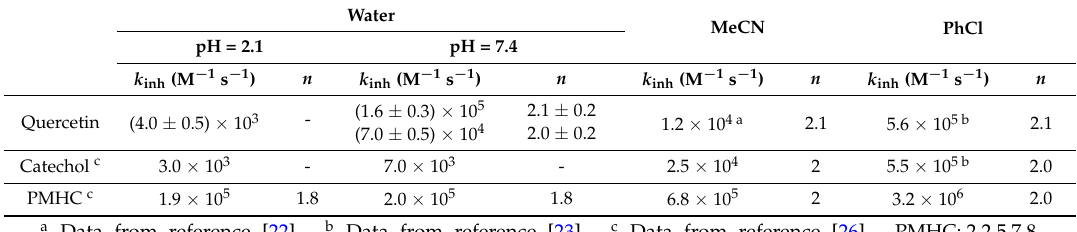
Table 1. Rate constants k inh and stoichiometric factors n for the trapping of peroxyl radicals by quercetin and reference antioxidants, measured in the inhibited autoxidation of tetrahydrofuran (THF) in buffered water at 303 K. Reference values in other solvents are reported for comparison. Water MeCN PhCl pH = 2.1 pH =